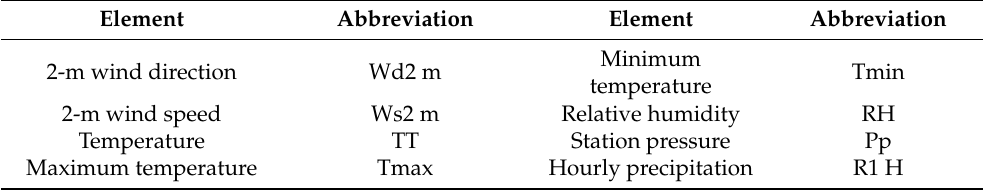
Table 2. The selected observation elements and their abbreviations.